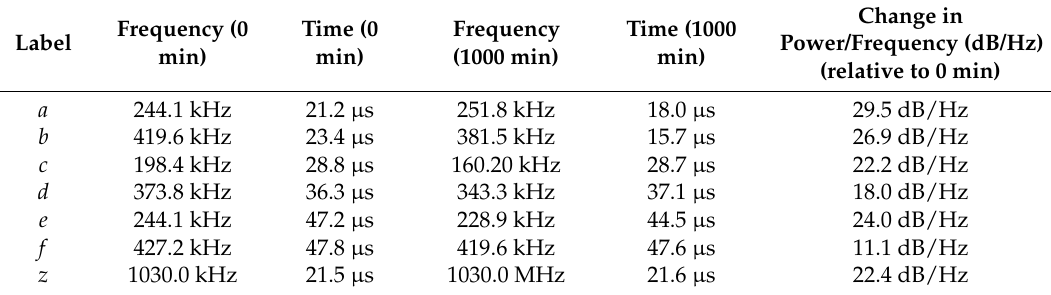
Table 5. Triangular specimen (Far): Wave